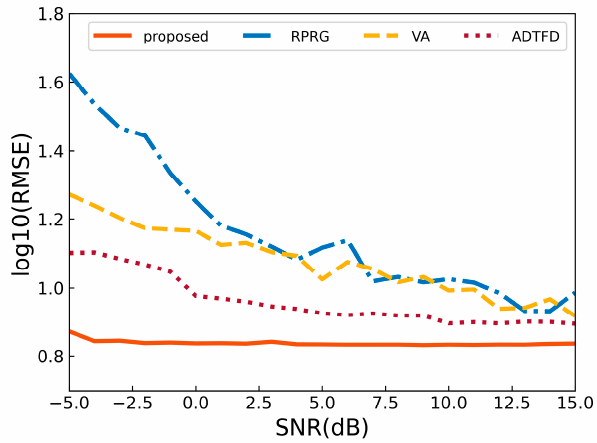
Figure 16. Comparison results of RMSE versus SNR.